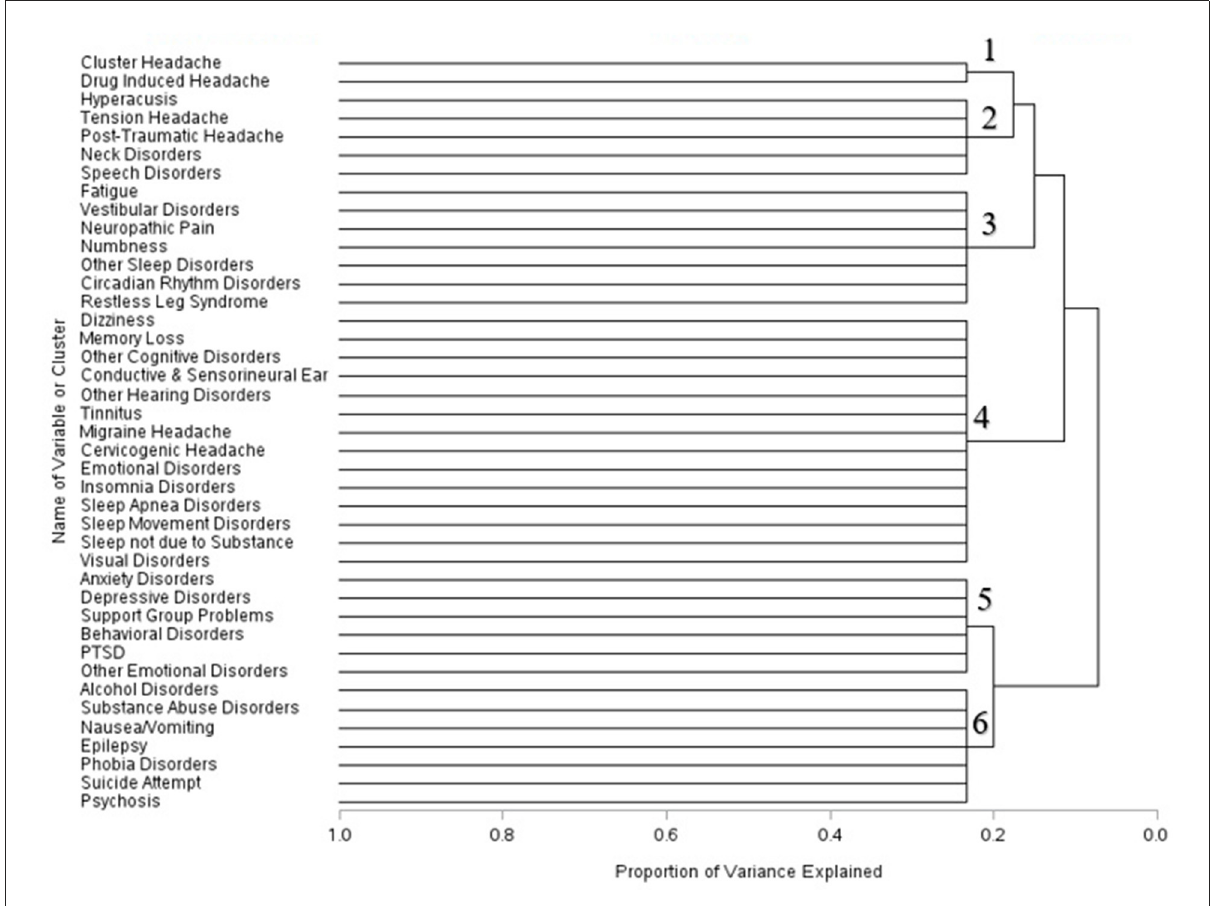
FIGURE3 Dendrogram of condition clusters among mTBI patients one